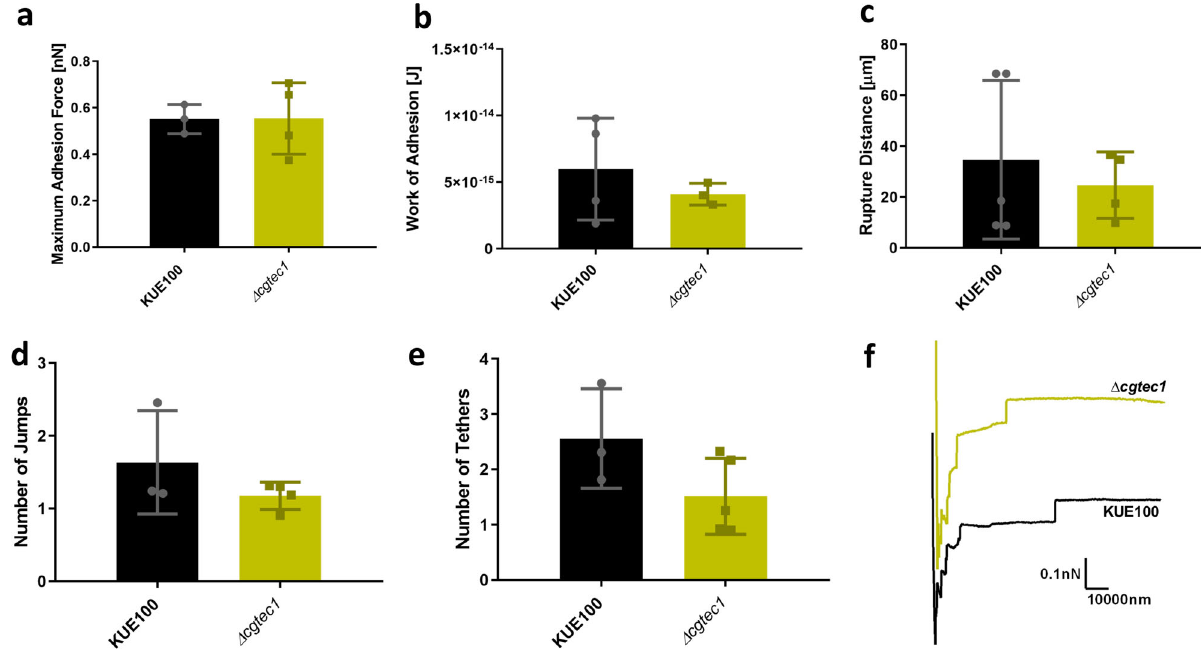
Fig. 10 Interaction of C. glabrata wild-type strain KUE100 (black) and deletion mutant Δ cgtec1 (green) with human vaginal epithelial VK2/E6E7 cells by SCFS, using 5 s of contact time. Characterization of these interactions is based on the: a maximal adhesion force, b work of adhesion, c rupture distance, d number of jumps, and e number of tethers measured on each retraction curve. f Representative force – distance curves of the interaction of C. glabrata wild-type KUE100 (black) and Δ cgtec1 deletion mutant single cells (green) with epithelial cells. Horizontal lines indicate the average levels from at least four yeast cells, from at least three independent cultures, immobilized on the cantilever for the interaction with epithelial cells. Sixty-four force – distance curves were recorded. Error bars indicate SDs, n ≥